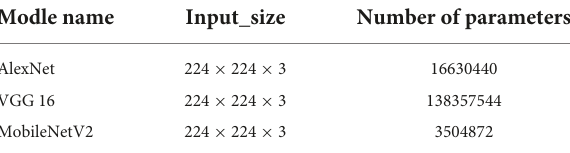
TABLE 1 Comparison of model parameters.